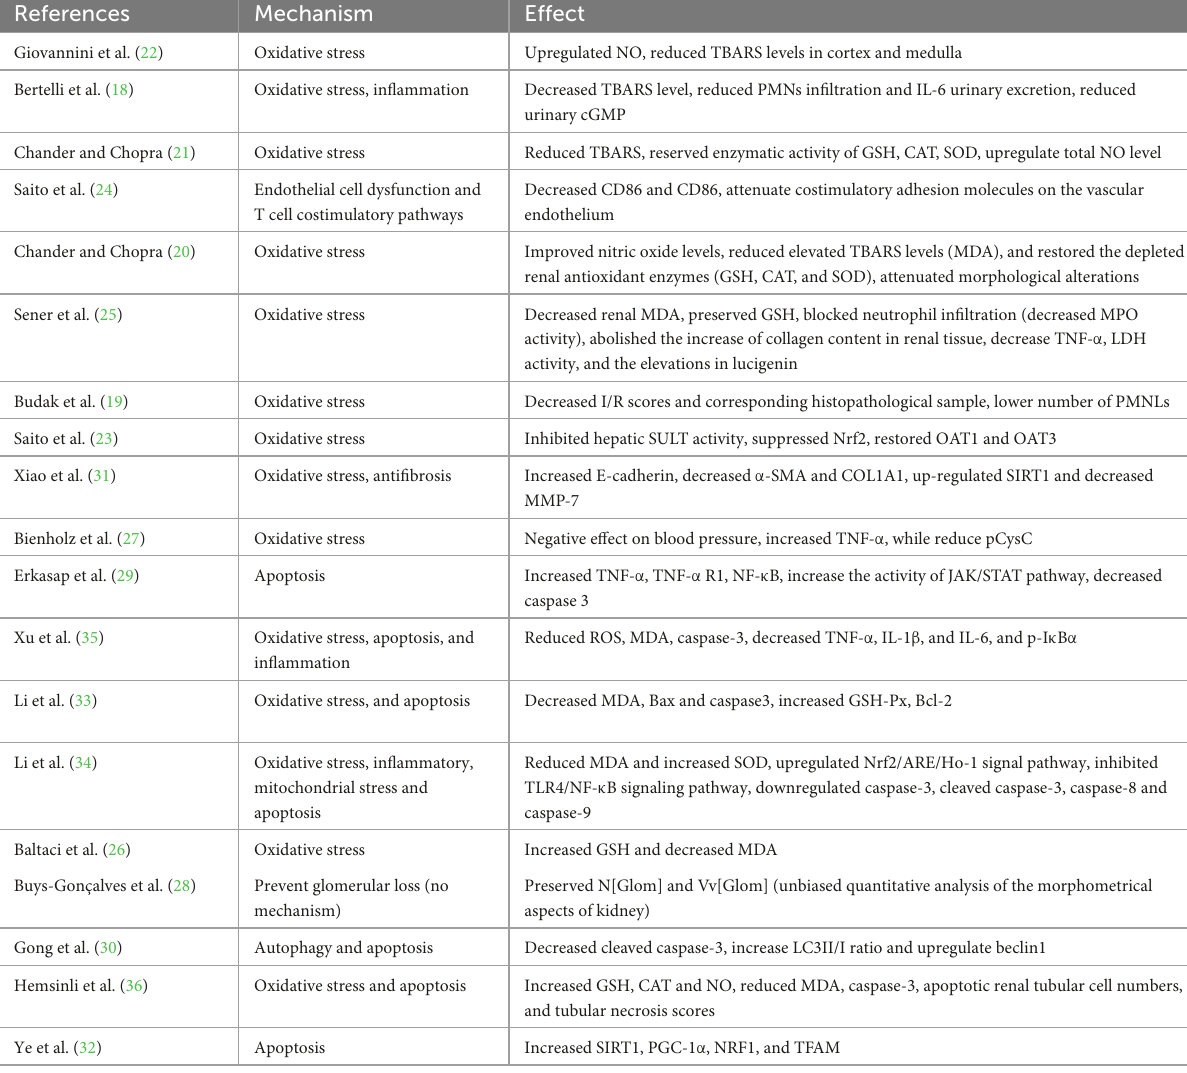
TABLE 5 The proposed molecular and cellular mechanism of the protective effect of resveratrol for renal I/R